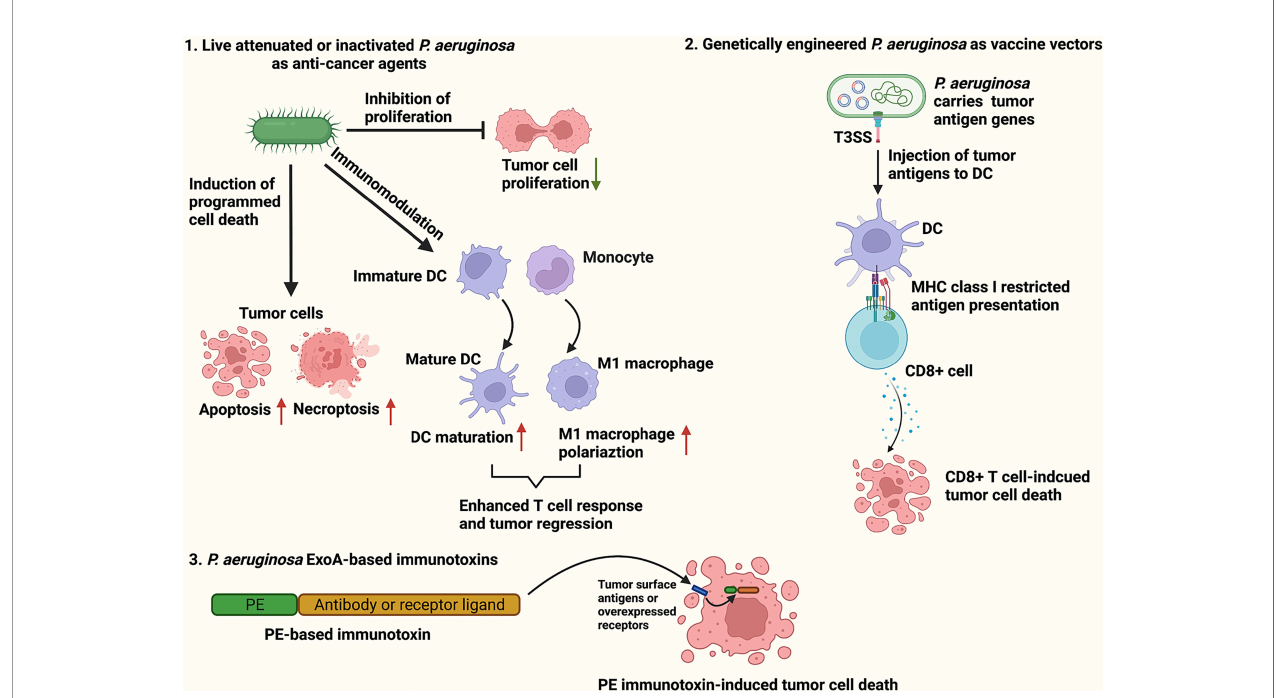
FIGURE 1 | Schematic illustration of P. aeruginosa -based cancer therapies. The P. aeruginosa -based therapeutic strategies for cancer treatment include live attenuated or inactivated P. aeruginosa as anti-cancer agents (1), P. aeruginosa as vaccine vectors for tumor antigen delivery (2), and P. aeruginosa ExoA-based immunotoxins